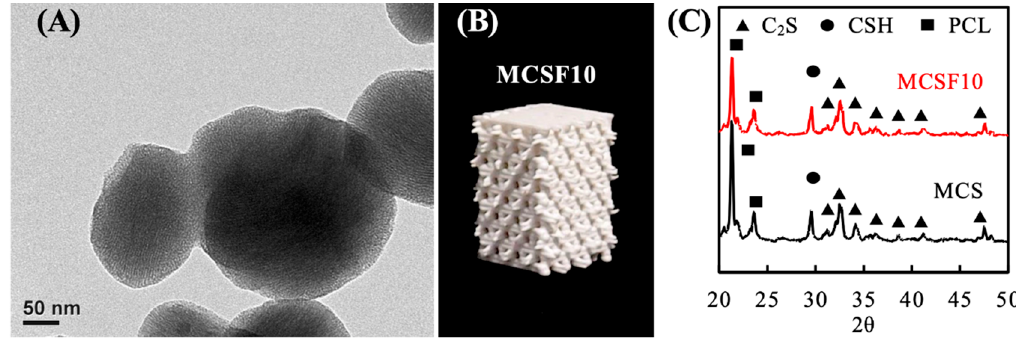
Figure 1. (A) TEM micrograph of calcium silicate-based mesoporous nanoparticles (MCS). (B) Photographs of the polycaprolactone (PCL)/MCSF10 scaffold fabricated through deposition of the molten struts layer-by-layer in a laydown pattern of 0°/90°. (C) XRD patterns of MCS- and MCSF10- incorporated PCL